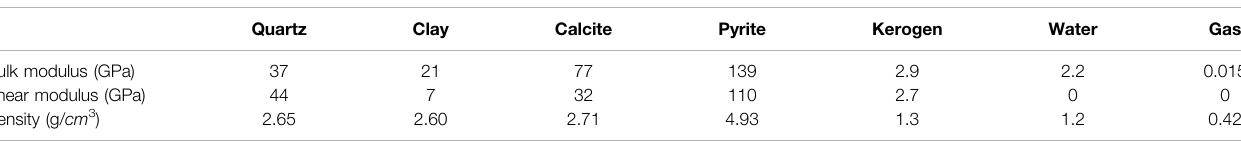
TABLE 1 | The bulk, shear moduli and density of the primary minerals and fl uids in shale. Quartz